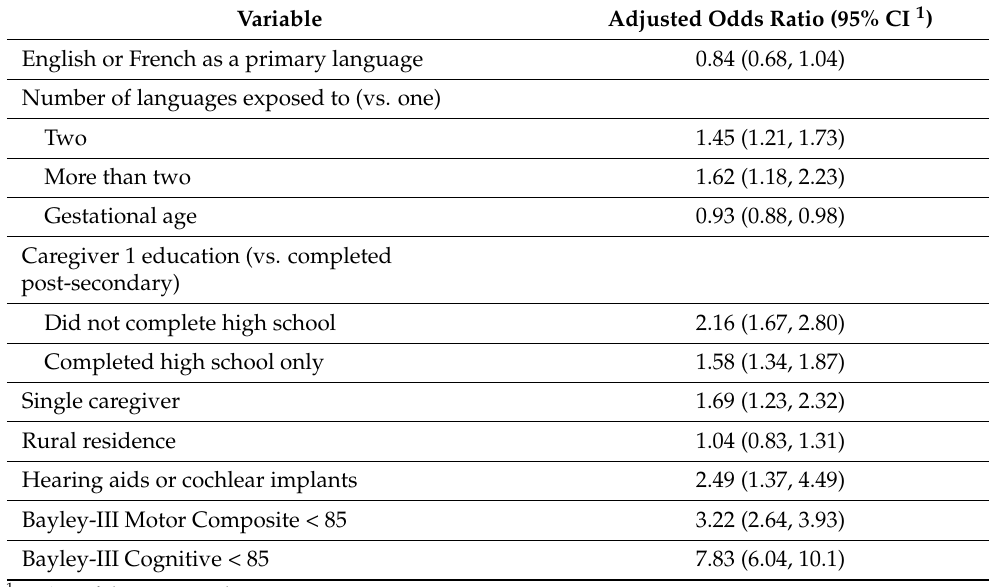
Table 5. Factors affecting odds of Bayley-III Language Scores < 85—by primary language (multivari- ate analysis).